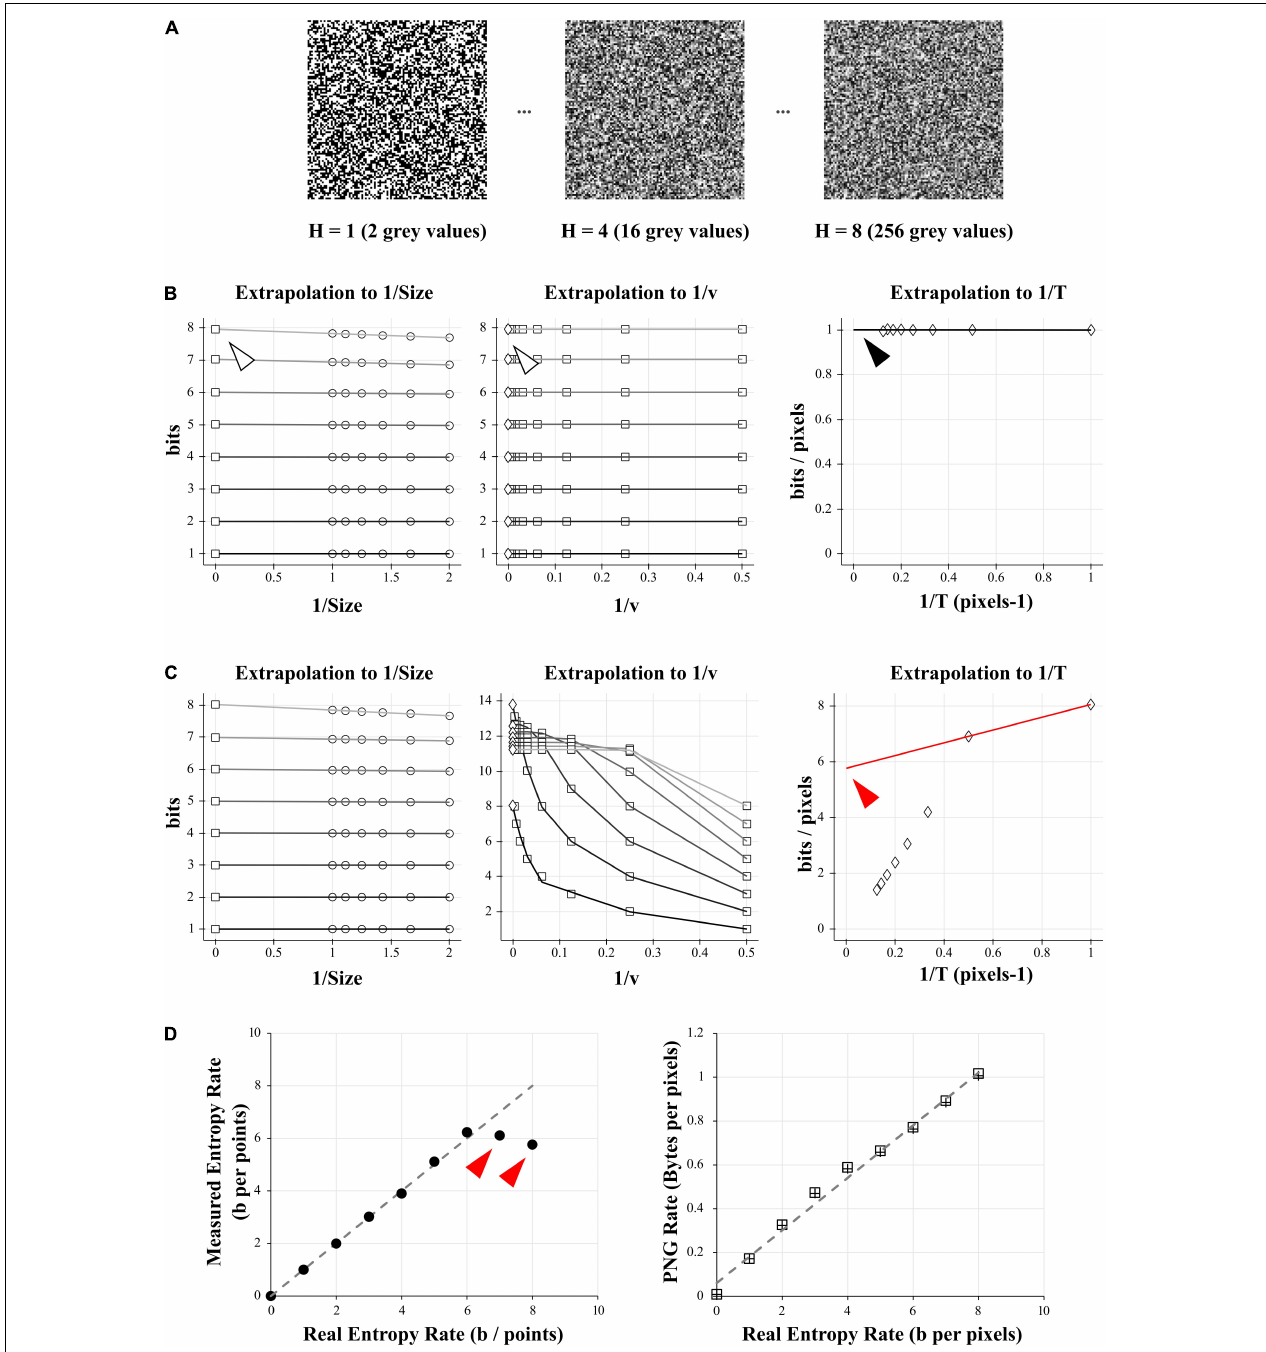
FIGURE 1 | Comparison of entropy and PNG file size on a model case. (A) Examples of 10 000 data points of white-noise-like signal with growing number of gray levels and growing entropy (here showed as square picture signals). Left: 2 possible gray values, or entropy of 1 bit. Middle: 16 possible gray values, or entropy of 4 bits. Right: 256 possible gray values, or entropy of 8 bits. (B) Direct calculation and quadratic extrapolations to 0 to calculate the entropy rate of the 1 bit- signal (left signal in A ). Left: Plotting all the entropy values to 1/ Size and extrapolating to 0 to get the value for infinite size (white arrowhead). For clarity, only the condition for v = 2 is shown (but this was done for v equal to 2, 4, 8, 16, 32, 64, 128, and 256). Middle: Plotting the limits values obtained for 1/ Size = 0 (left graph) versus 1/ v and extrapolating to 0 to get the value for infinite number of quantization levels (white arrowhead). Right: Plotting the limits values obtained for 1/ v = 0 (middle graph) versus 1/ T and extrapolating to 0 to get the value for infinite number of combinations bins (black arrowhead). Note that this value is close to 1 bit/pixel, as expected when using a signal made of uniform white noise with 2 possible values. (C) Direct calculation and quadratic extrapolations to 0 to calculate the entropy rate of the 8 bits- signal (right signal in A ). Left: Plotting all the entropy values to 1/ Size and extrapolating to 0 to get the value for infinite size. For clarity, only the condition for